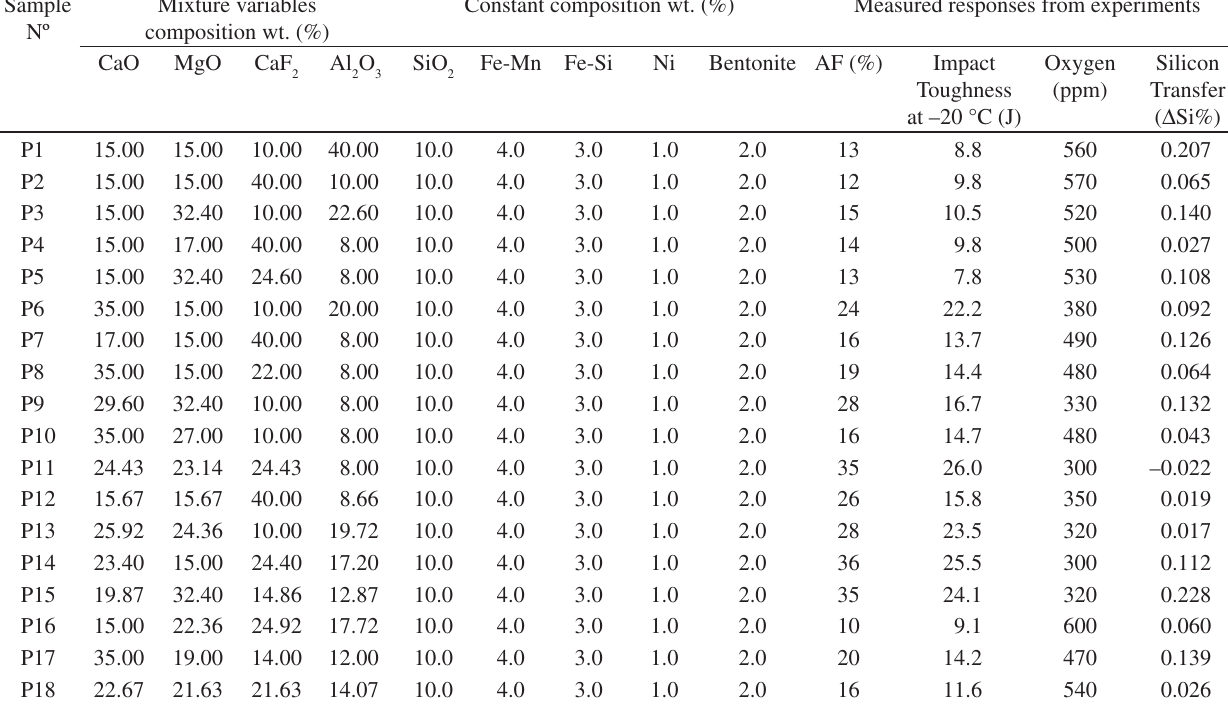
Table 1. Treatment combination determined by the XVERTD design and results of the experiments. Sample Mixture variables Nº composition wt. (%)